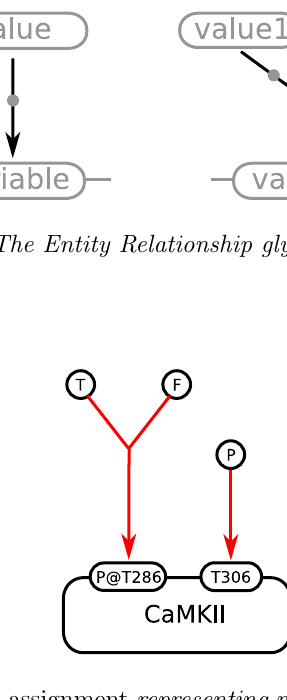
Figure 2.14: Two examples of assignment representing phosphorylation, by one value (phos- phorylation) of a variable representing a residue, or two values (true or false) of a variable representing the phosphorylated